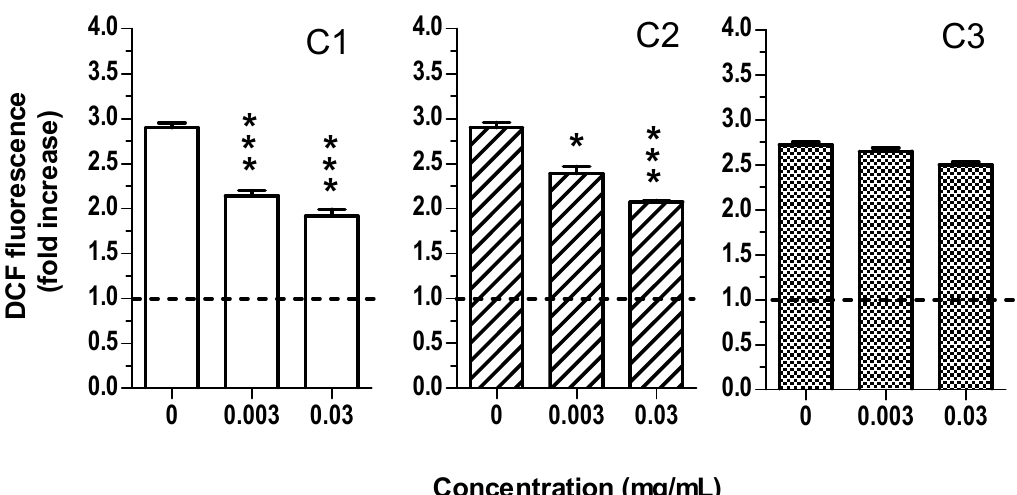
Figure 4. C1 and C2, but not C3, extracts reduce oxidative stress induced by H 2 O 2 in HaCaT cells. Cells were treated with various concentrations of extract (0.003–0.03 mg/mL) for 2 h and then treated with H 2 O 2 (100 µM) for 30 min. At the end of treatment, intracellular oxidative stress was evaluated using the probe DCFH 2 -DA, as described in the method section. Data are expressed as fold increase of fluorescent DCF formation versus untreated cells and reported as mean ± SEM of three independent experiments (*** p < 0.001 vs. cells treated with H 2 O 2 ; one-way ANOVA with Dunnett post hoc test).